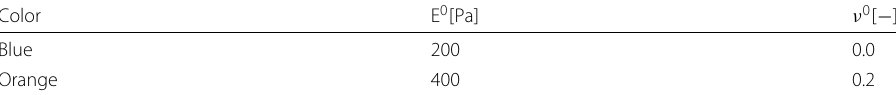
Table 4 Initial guesses for different inverse analysis runs in heterogeneous example with simplificat- ion to homogeneous assumption Color E 0 [Pa] ν 0 [ − ] Blue 200 0.0 Orange 400